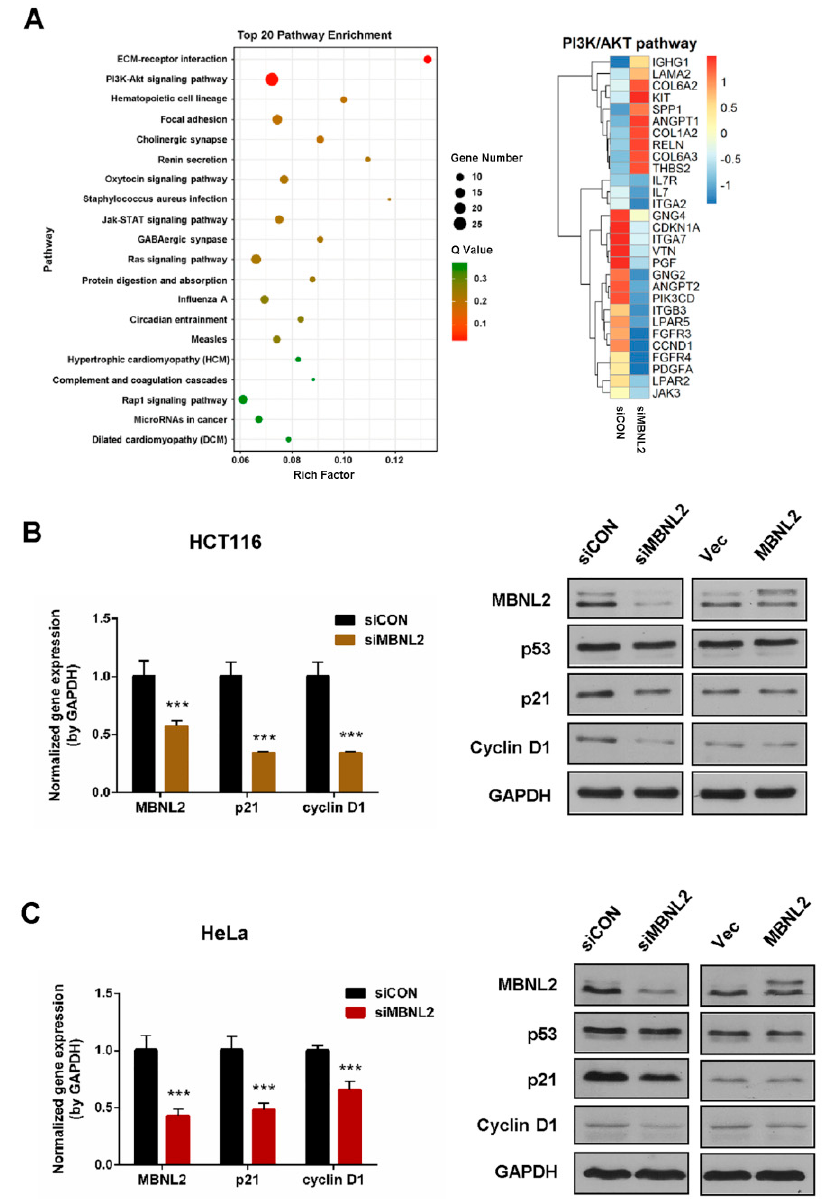
Figure 1. MBNL2 regulates p21 expression. ( A ) KEGG pathway enrichment analysis of RNA-seq data in the HCT116 cells transfected with control or MBNL2 siRNAs (left). The Rich factor refers to the ratio of the number of the differentially expressed genes to the total number of annotated genes. Normalized gene enrichment score of gene sets in the PI3K/AKT pathway was specially analyzed in detail (right). ( B ) HCT116 cells were transfected with control or MBNL2 siRNA, empty vector, or MBNL2-myc plasmids and subjected to qRT-PCR and immunoblotting analysis. ( C ) qRT-PCR and immunoblotting analysis in HeLa cells transfected with control or MBNL2 siRNA, empty vector, or MBNL2-myc plasmids. Abbreviations: si, siRNA; CON, control; Vec, vector. *** p < 0.001.